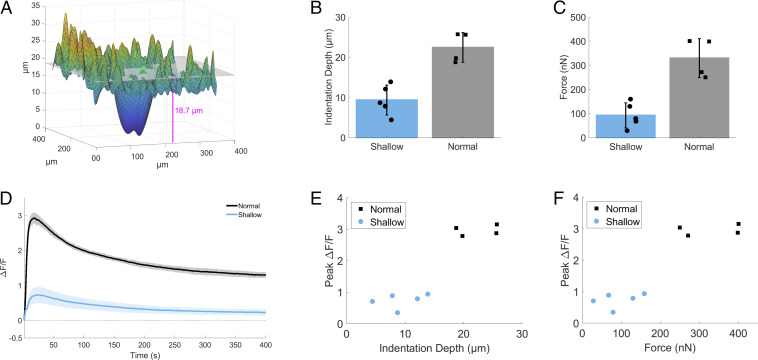
mSLED optimization and force calculations. (A) Z-stack images of mSLED-stimulated cells were used to map the indentation of the cell monolayer by pipette. The indentation depth of the cell monolayer was quantified using the difference between the average monolayer baseline (Top) and bottom hundredth percentile of the indentation (Bottom). In addition, forces applied by pipette onto cells were calculated using the indentation depth (d), known elastic modulus of substrate (E = 0.2 kPa), and pipette radius (R) = 80 µm, using the Hertzian contact mechanics equation for a rigid sphere indenter F= (4/3)(E/(1−υ2))R1/2d3/2. (B and C) Two depths of pipette compression were tested (Normal vs. Shallow), which show average differences in indentation depth (Normal, 22.5 ± 3.7 µm; Shallow, 9.4 ± 3.7 µm) and average force applied to cells (Normal, 330.1 ± 80.9 nN; Shallow, 92.7 ± 51.8 nN). (D) Calcium signaling in response to alternate modes of mSLED stimulation resulted in different relative changes in peak fluorescence (peak ΔF/F) (Normal, 2.9 ± 0.16, vs. Shallow, 0.74 ± 0.23) and persistent fluorescence (ΔF/F at 6 min) (Normal, 1.3 ± 0.09, vs. Shallow, 0.24 ± 0.09). (E and F) A difference in average indentation depth of ∼13.1 µm, or average force of ∼237.3 nN, resulted in a threefold increase in intracellular calcium signaling.